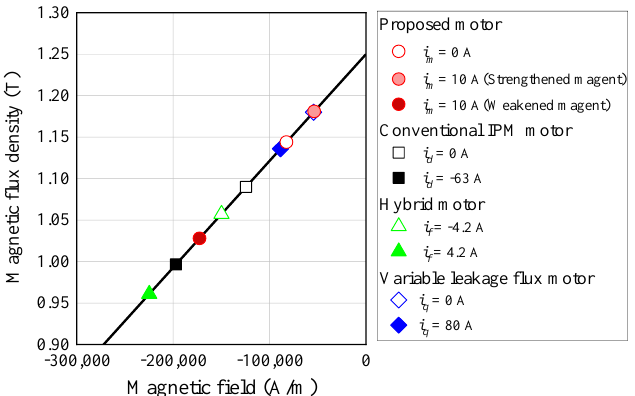
Figure 21. B–H characteristic of N39UH and PM operating points of each compared motor.